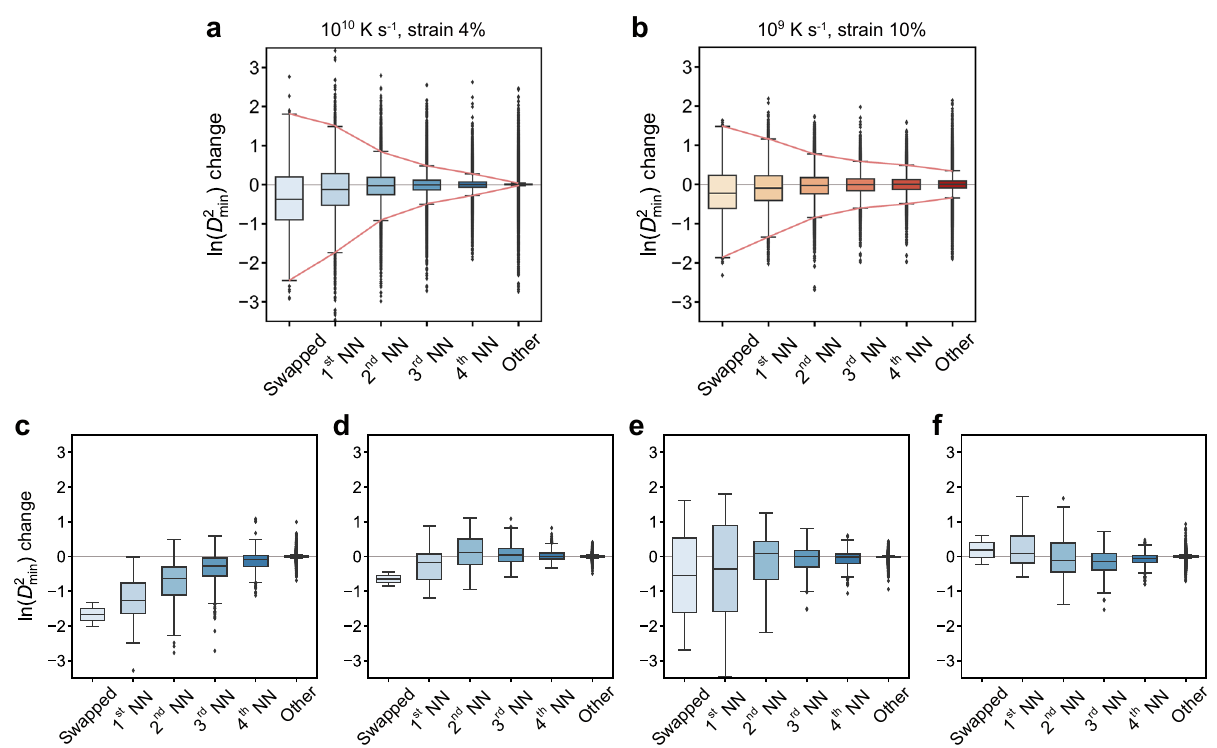
) change after each optimization step when using ( a ) GNN model for strain 4% to Fig. 4 The strengthening mechanism. a , b Statistics of ln( D 2 min strengthen Cu 50 Zr 50 – 10 10 K s − 1 and ( b ) GNN for strain 10% to strengthen Cu 50 Zr 50 − 10 9 K s − 1 . Atoms are grouped into six categories: the swapped atoms, 1st, 2nd, 3rd, and 4th neighbors of the swapped atoms, and all the other atoms. All the accepted steps are included in the statistics. In the box plots, ends of box spans from 25 – 75% percentile, black line in the box represents the median, whiskers show 1.5 times the inter-quartile range, and points outside the whiskers show outliers. c – f Typical ln( D 2 ) change in a single optimization min